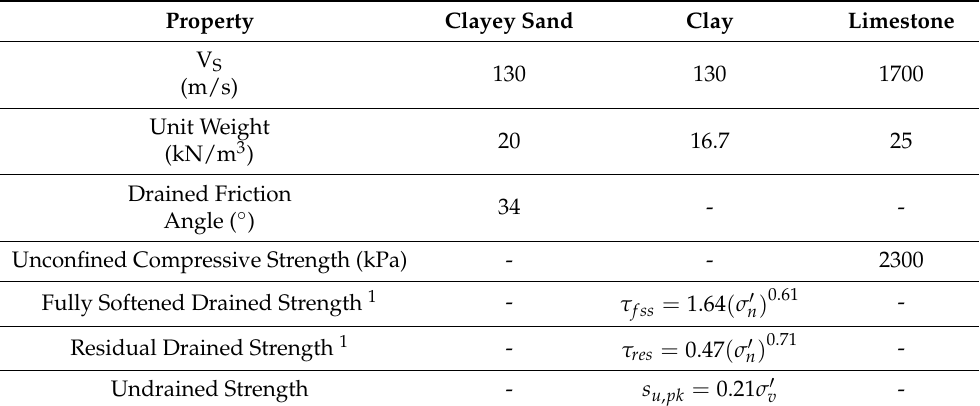
Table 2. Properties of the various layers used for the slope stability